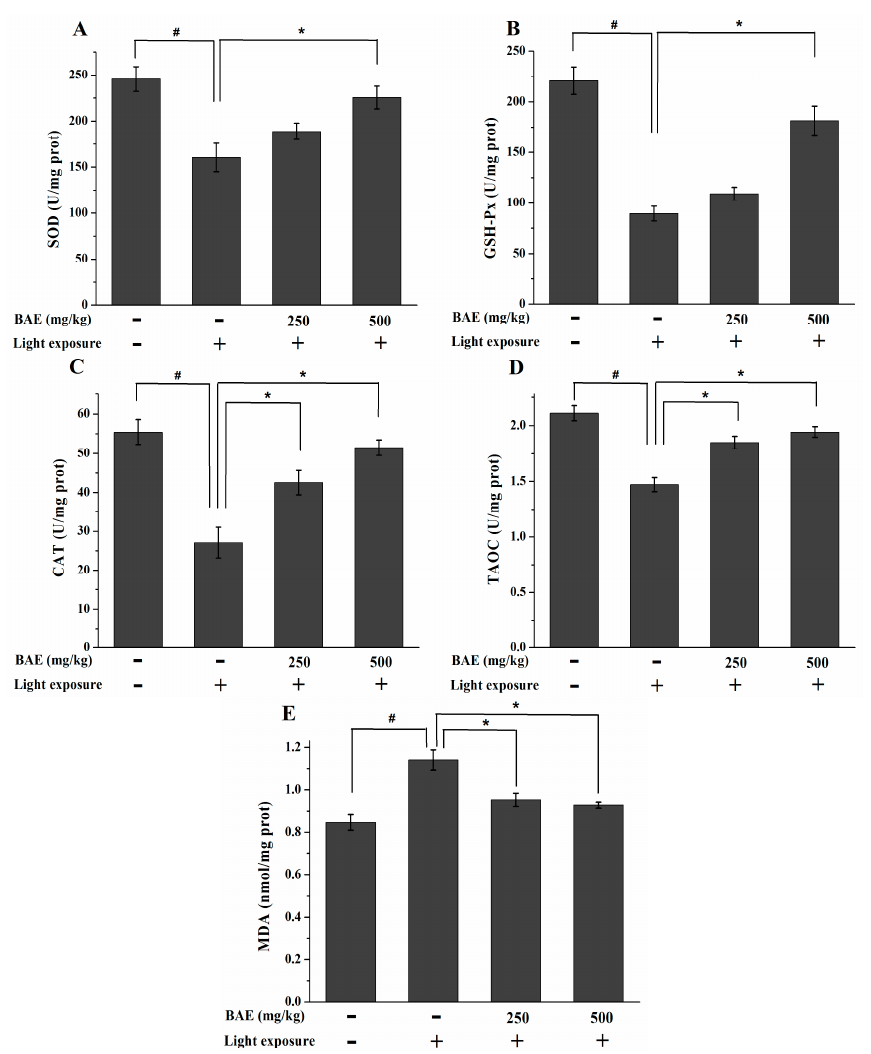
Figure 5. Changes in ( A ) SOD; ( B ) GSH-Px; and ( C ) CAT activities; as well as the ( D ) TAOC and ( E ) MDA levels, in the retina at 7 d after light exposure (18,000 lx). Data are expressed as the mean ± standard deviation ( n = 8). #, * p < 0.05 ( t -test). SOD: superoxide dismutase; GSH-Px: glutathione peroxidase;